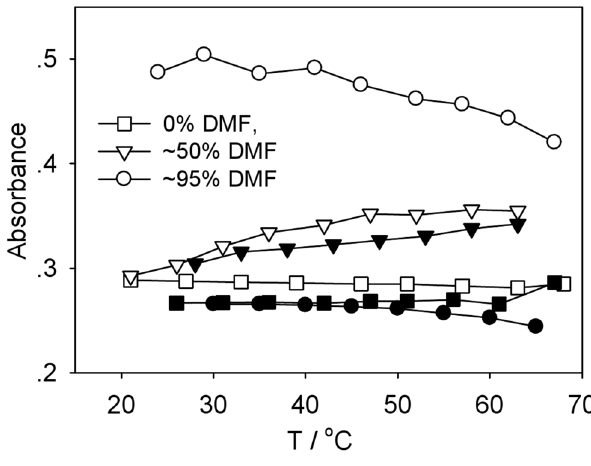
Figure 2. Thermal denature curves of calf thymus and plasmid DNA. Plasmid DNA: hollow symbols; calf thymus DNA: solid symbols. C=16 m g/mL.